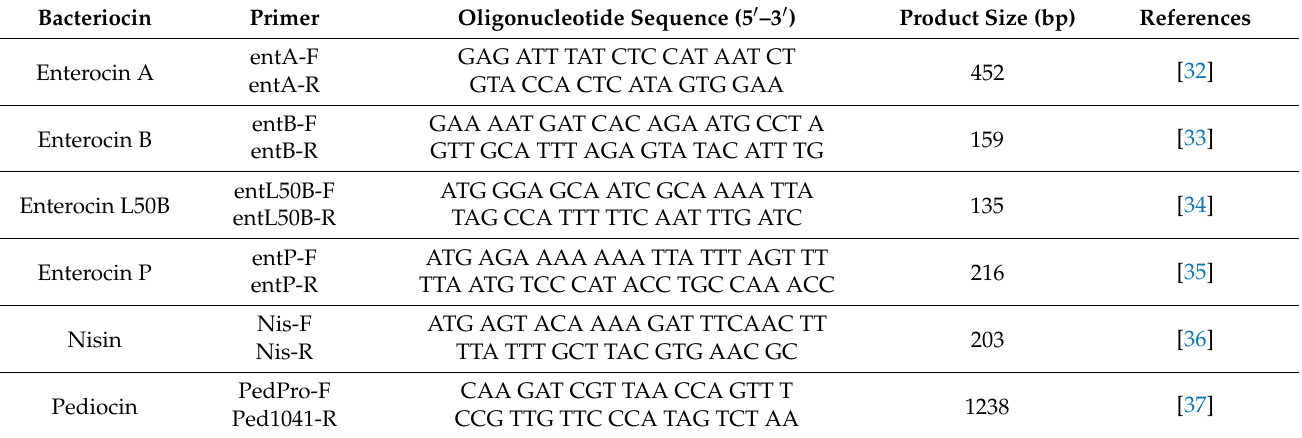
Table 1. Primers used in this study for the detection of bacteriocin-associated genes.